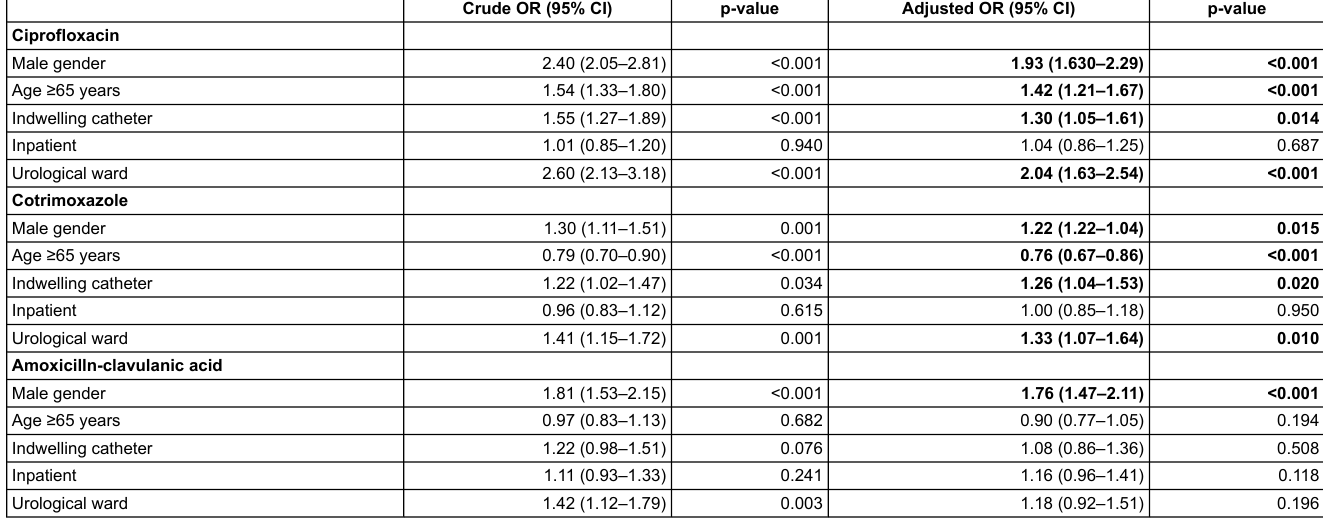
Table 3: Uni- and multivariable analysis of risk factors for E. coli resistance to commonly used antimicrobial agents.